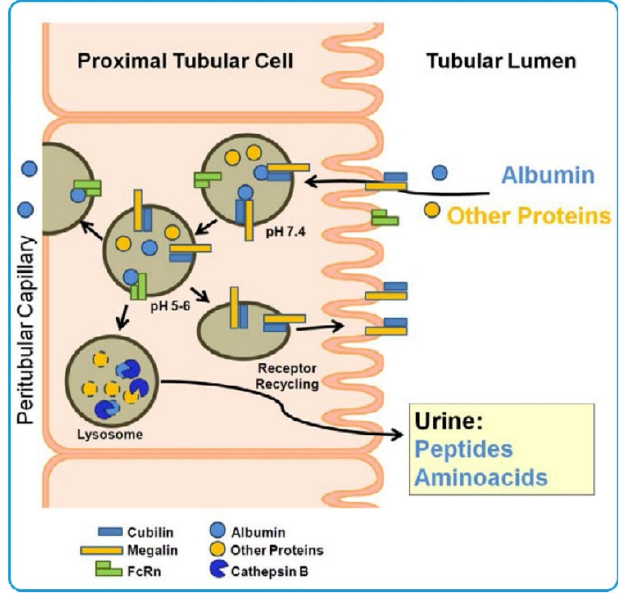
Figure 2. Albumin (blue) and other proteins (yellow), after binding to megalin/cubilin complex on the brush border of proximal tubular cells, are internalised, via clathrin-coated vesicles, that fuse to early endosomes. Acidification of these endosomes causes dissociation of albumin from the megalin/cubilin complex, but, at pH 5–6, albumin binds to FcRn and undergoes transcytosis. The megalin/cubilin complex is recycled to the apical brushborder membrane, while unbound albumin and other proteins are transferred to lysosomes for degradation by cathepsin B and other lysosomal proteases. Degradation products are exocytosed into the tubular lumen and excreted in the urine. (after [85]). Creative Commons Attribution